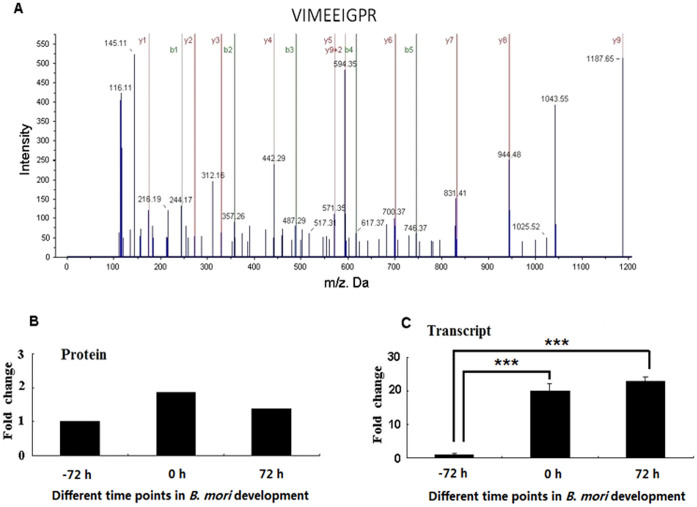
Characterization of glycerol-3-phosphate O-acyltransferase (GPAT).(A) The MS/MS spectrum for a peptide fragment sequence (VIMEEIGPR) of GPAT. (B) GPAT protein level based on proteomics results and (C) GPAT transcript level in different time points in B. mori development. PGs at different time points in B. mori development were dissected and total RNA was extracted for qPCR analysis. The Rp49 gene was used as the housekeeping gene for normalization. The data represent the mean values ± SD of three biological replicates. Significance of comparisons are marked with *** (p < 0.01) as determined by the Student's t-test.